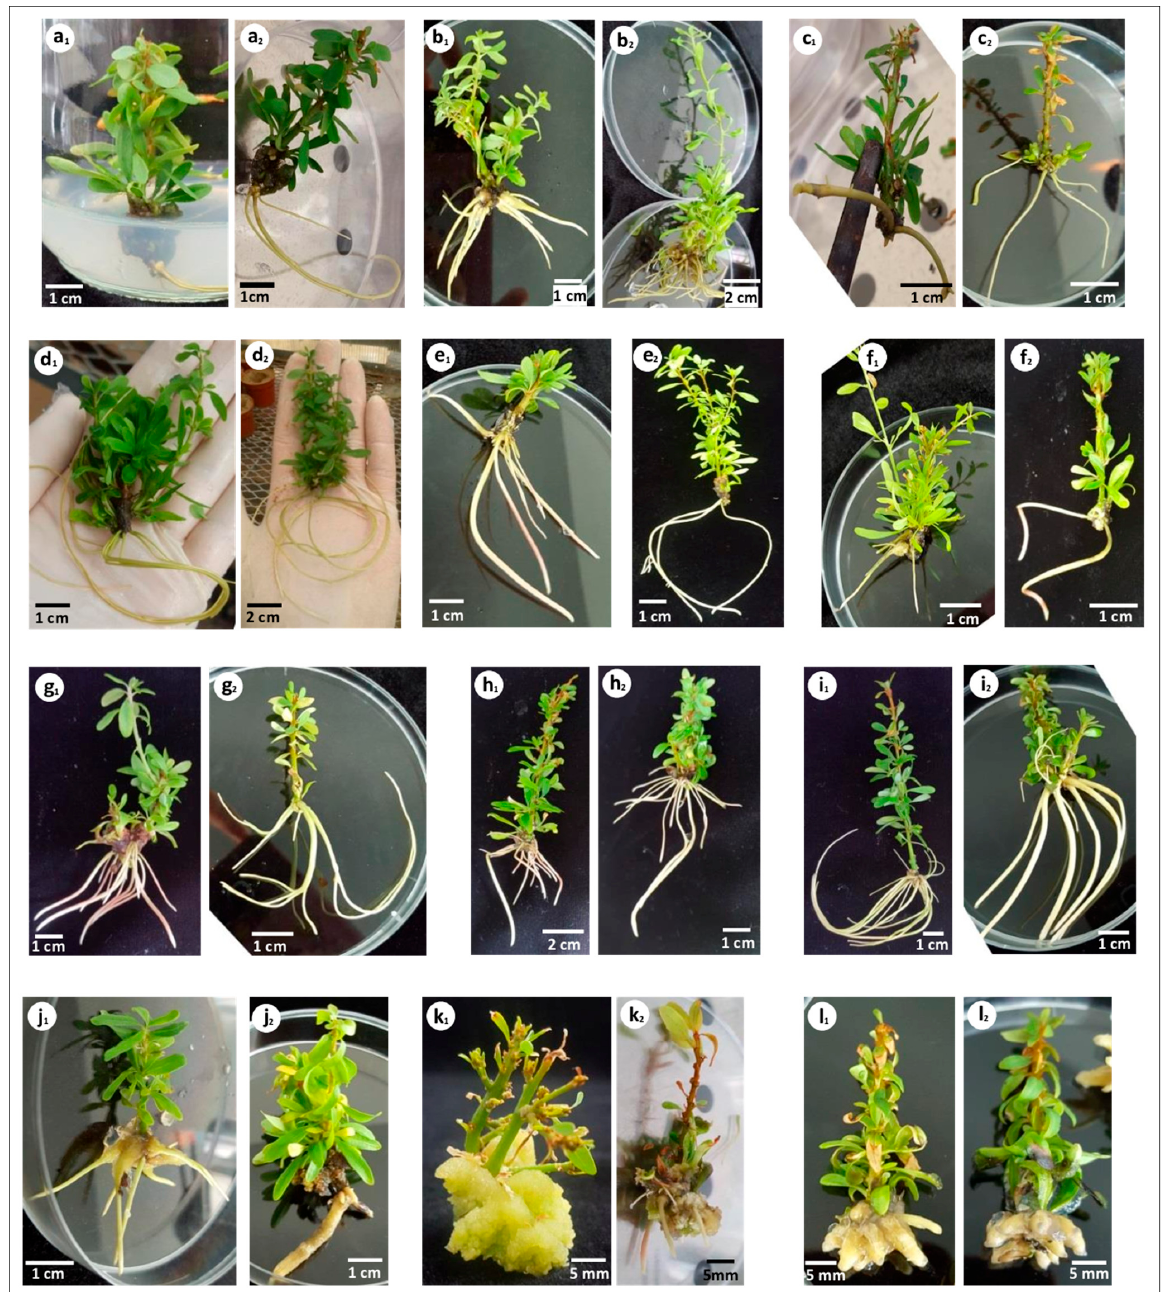
Figure 2. In vitro rooting of different argan genotypes. ( a ) In vitro rooting in the presence of putrescine and indole-3-butyric acid (IBA) in Murashige and Skoog (MS) medium; ( b ) in vitro rooting in the presence of putrescine and IBA in MS medium modified by reducing ammonium nitrate concentration to 825 mg L − 1 (RM medium); ( c ) in vitro rooting in the presence of putrescine and IBA in MS medium without ammonium nitrate (M medium); ( d ) in vitro rooting in the presence of silver nitrate (AgNO 3 ) (2 mg L − 1 ) and IBA; ( e ) in vitro rooting in the presence of AgNO 3 (4 mg L − 1 ) and IBA; ( f ) in vitro rooting in the presence of AgNO 3 (6 mg L − 1 ) and IBA; ( g ) in vitro rooting in the presence of AgNO 3 (2 mg L − 1 ), putrescine and IBA; ( h ) in vitro rooting in RM medium containing AgNO 3 (2 mg L − 1 ), putrescine and IBA; ( i ) in vitro rooting in RM medium containing AgNO 3 (2 mg L − 1 ), putrescine, IBA and 1-naphthalene acetic acid (NAA) (0.5 mg L − 1 ); ( j ) in vitro rooting in RM medium containing AgNO 3 (2 mg L − 1 ), putrescine, IBA and NAA (1 mg L − 1 ); ( k ) in vitro rooting in RM medium containing AgNO 3 (2 mg L − 1 ), putrescine, IBA and NAA (1.5 mg L − 1 ); ( l ) in vitro rooting in RM medium containing AgNO 3 (2 mg L − 1 ), putrescine and NAA (1.5 mg L − 1 ). ( 1 ) indicates genotype “Mejji”, and ( 2 ) indicates genotype